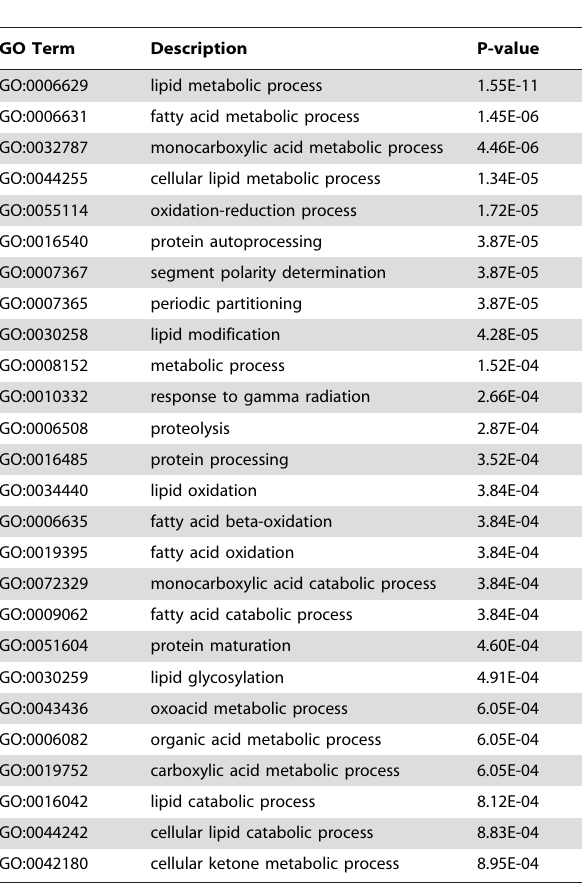
Table 2. Occurrence of gene families in microarray results for NHR-49, based on